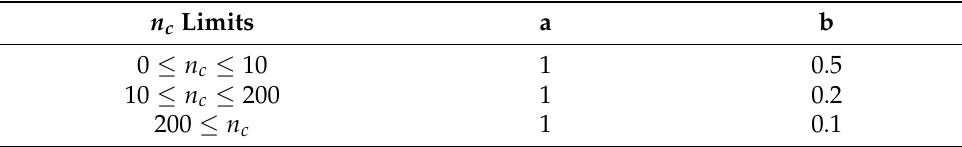
Table 4. Adaptive T max model